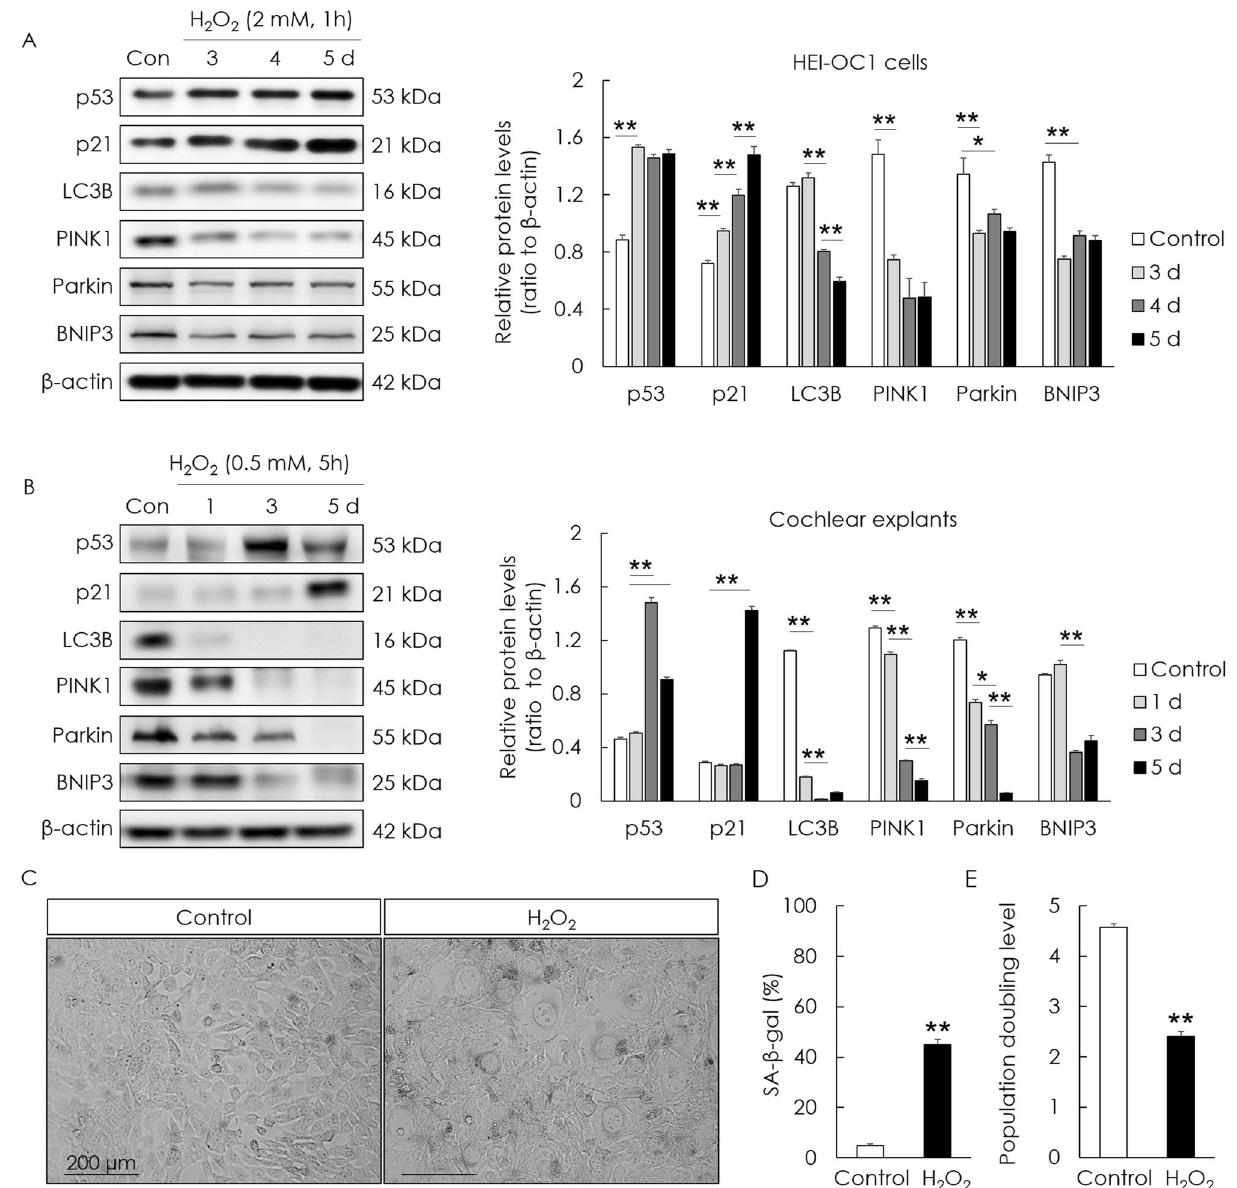
Figure 1. H 2 O 2 -induced senescence and changes in mitophagy-related proteins in HEI-OC1 cells and cochlear explants. HEI-OC1 cells were exposed to 2 mM H 2 O 2 for 1 h and incubated for 3, 4, and 5 days. Whole cochleae also were exposed to 0.5 mM H 2 O 2 for 5 h and incubated for 1, 3, and 5 days. The levels of p53 and p21 (cellular senescence markers) increased in H 2 O 2 -treated HEI-OC1 cells ( A ) and cochlear explants ( B ). The levels of mitophagy-related proteins (PINK1, Parkin, BNIP3, and LC3B) significantly decreased in H 2 O 2 - treated HEI-OC1 cells ( A ) and cochlear explants ( B ). HEI-OC1 cells were exposed to 2 mM H 2 O 2 for 1 h and incubated for 5 days. β-galactosidase staining of senescent cells significantly increased in H 2 O 2 -treated cells ( C , D ). The population doubling level significantly decreased in H 2 O 2 -treated cells ( E ). Data are presented as means ± standard errors of the mean of five independent experimental results (SA-β-gal, senescence associated- beta galactosidase). * p < 0.05, ** p < 0.01. The grouping of gels/blots cropped from different parts of the same gel. Full-length blots are presented in Fig. S1A,